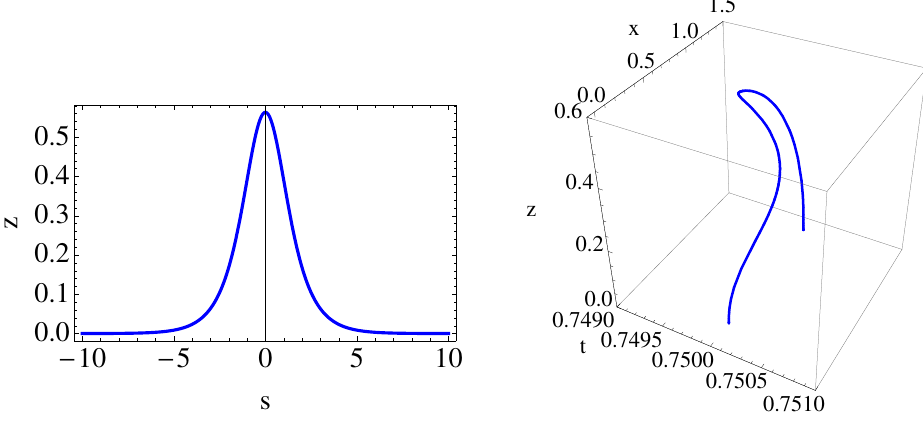
Figure 6 . Parametric dependence of the geodesic. (Left) We show z = z ( s ). (Right) Geodesic in the space ( t; x; z ). See (cid:12)gure 5 for further